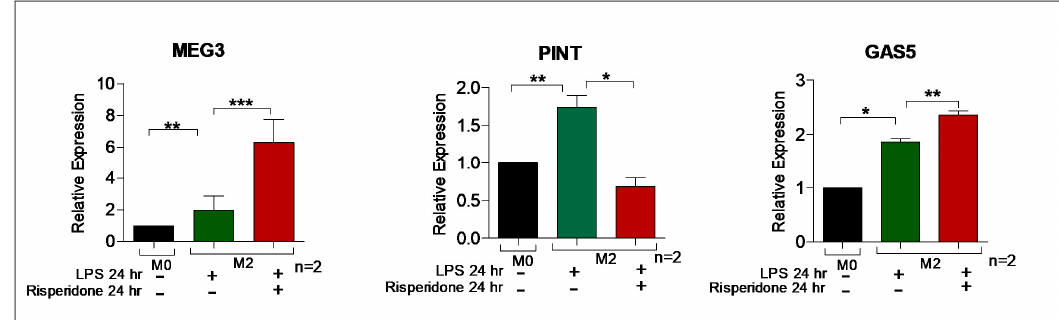
Figure 8. Antipsychotic response on induced M2 tol macrophages. MEG3 was significantly upregulated in response to LPS treatment, an effect compounded by Risperidone co-treatment, a pattern also seen with GAS-5. PINT was upregulated in response to LPS, but this effect was ablated with Risperidone treatment. The experiment was conducted in duplicate ( n = 2), and M2 tol levels are compared to M0 set arbitrarily as the baseline. * p < 0.05; ** p < 0.01; *** p < 0.001; ns, not significant, as determined by ANOVA ( n = 2).